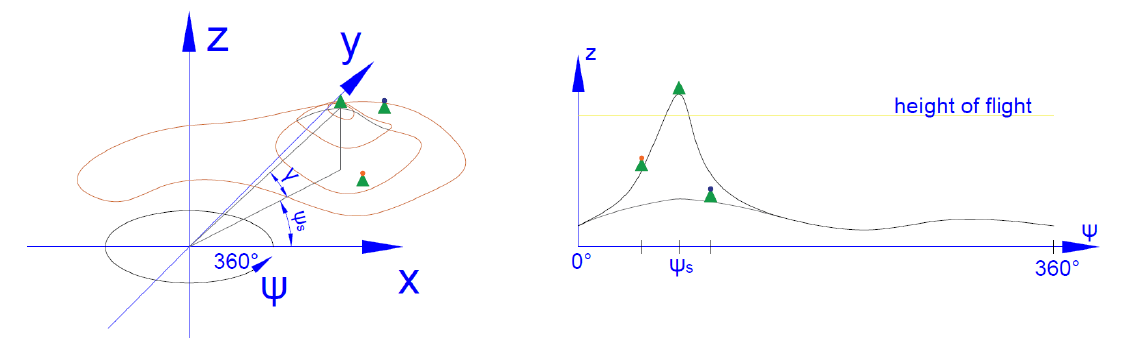
Figure 4. Histogram of terrain elevation in a cylindrical coordinate system. Part of terrain data are presented in the left figure. In the right figure, the histogram for this terrain data are